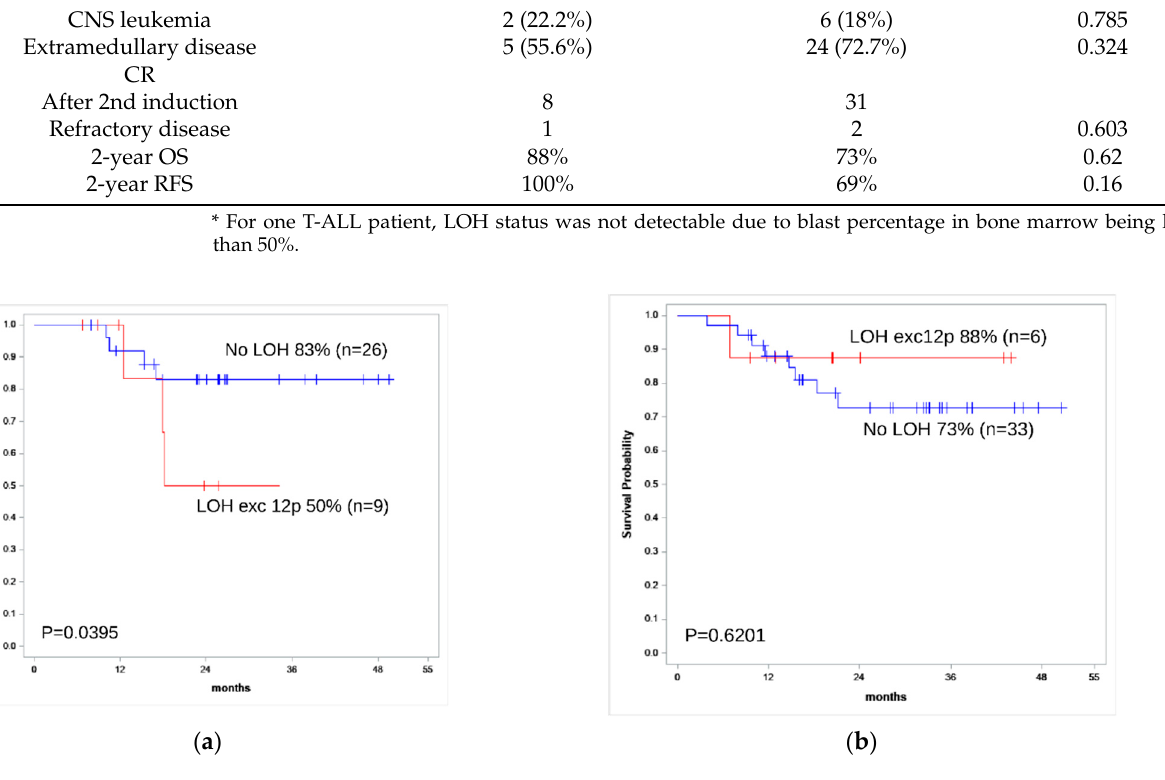
Table 3. The main characteristics of T-ALL patients according to the LOH status. p -value from χ 2 was used to estimate significance for the tables of 2 × 2.